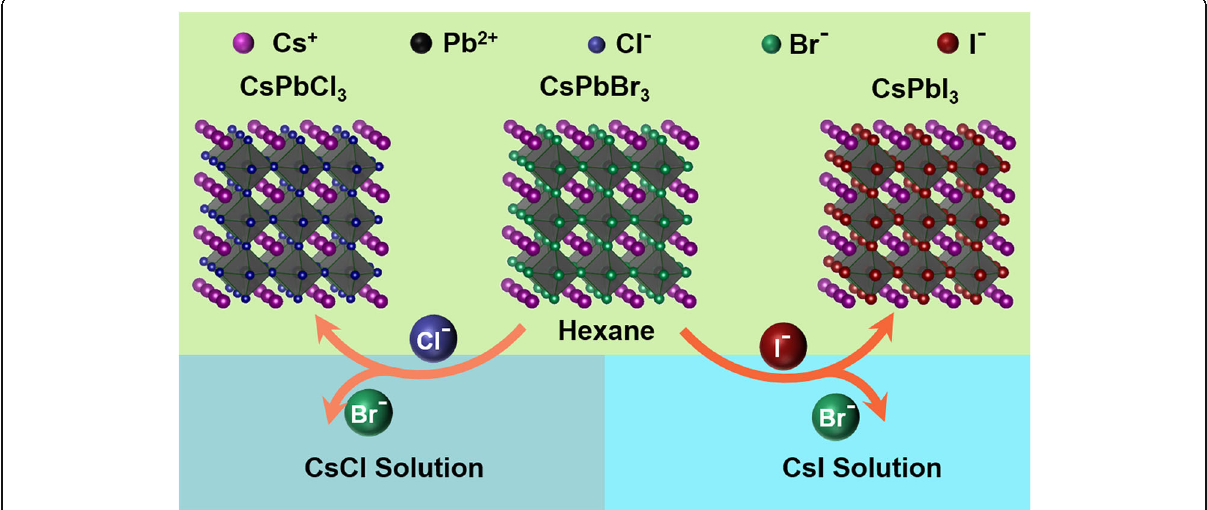
Fig. 1 Illustration of the mechanism for anion exchange of perovskite nanocrystals in aqueous